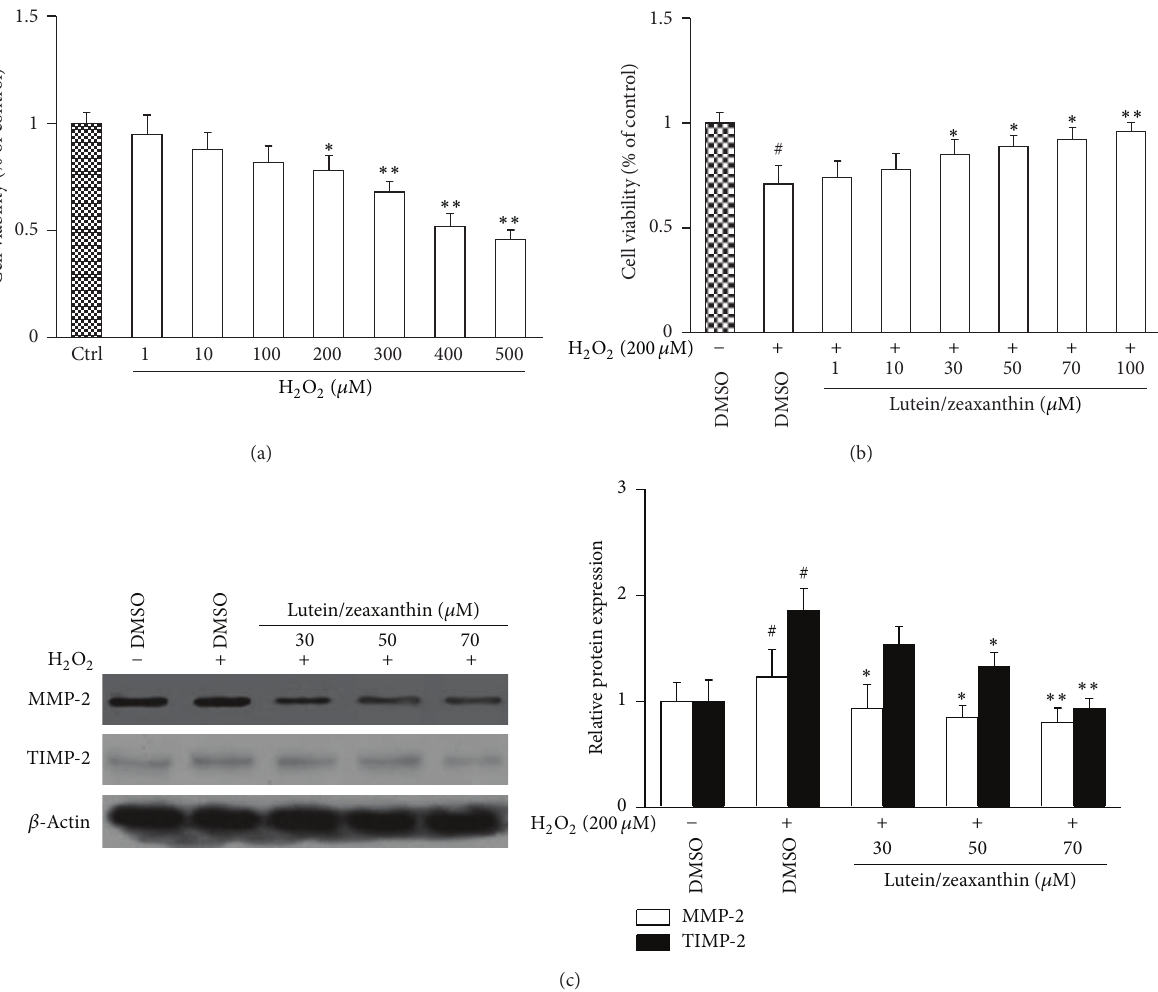
Figure 4: Effects of lutein/zeaxanthin on proliferation and MMP/TIMP system in ARPE-19 cells treated with H 2 O 2 . ARPE-19 cells were treated with H 2 O 2 , with or without lutein/zeaxanthin at the indicated concentrations for 24 h. Treatment with DMSO (0.02%, w/v) was set up as the negative control. (a) MTS assay for evaluation of cell viability. Data are expressed as mean ± SD, ∗ 𝑃 < 0.05 versus control, and ∗∗ 𝑃 < 0.01 versus control. (b) MTS assay for evaluation of cell viability. Data are expressed as mean ± SD, # 𝑃 < 0.05 versus DMSO without H 2 O 2 , ∗ 𝑃 < 0.05 versus DMSO with H 2 O 2 , and ∗∗ 𝑃 < 0.01 versus DMSO with H 2 O 2 . (c) Western blot analysis for protein levels of MMP-2 and TIMP-2. 𝛽 -Actin was used as an invariant control for equal loading. Representative blots were from three independent experiments with quantification. Data are expressed as mean ± SD, # 𝑃 < 0.05 versus DMSO without H 2 O 2 , ∗ 𝑃 < 0.05 versus DMSO with H 2 O 2 , and ∗∗ 𝑃 < 0.01 versus DMSO with H 2 O 2